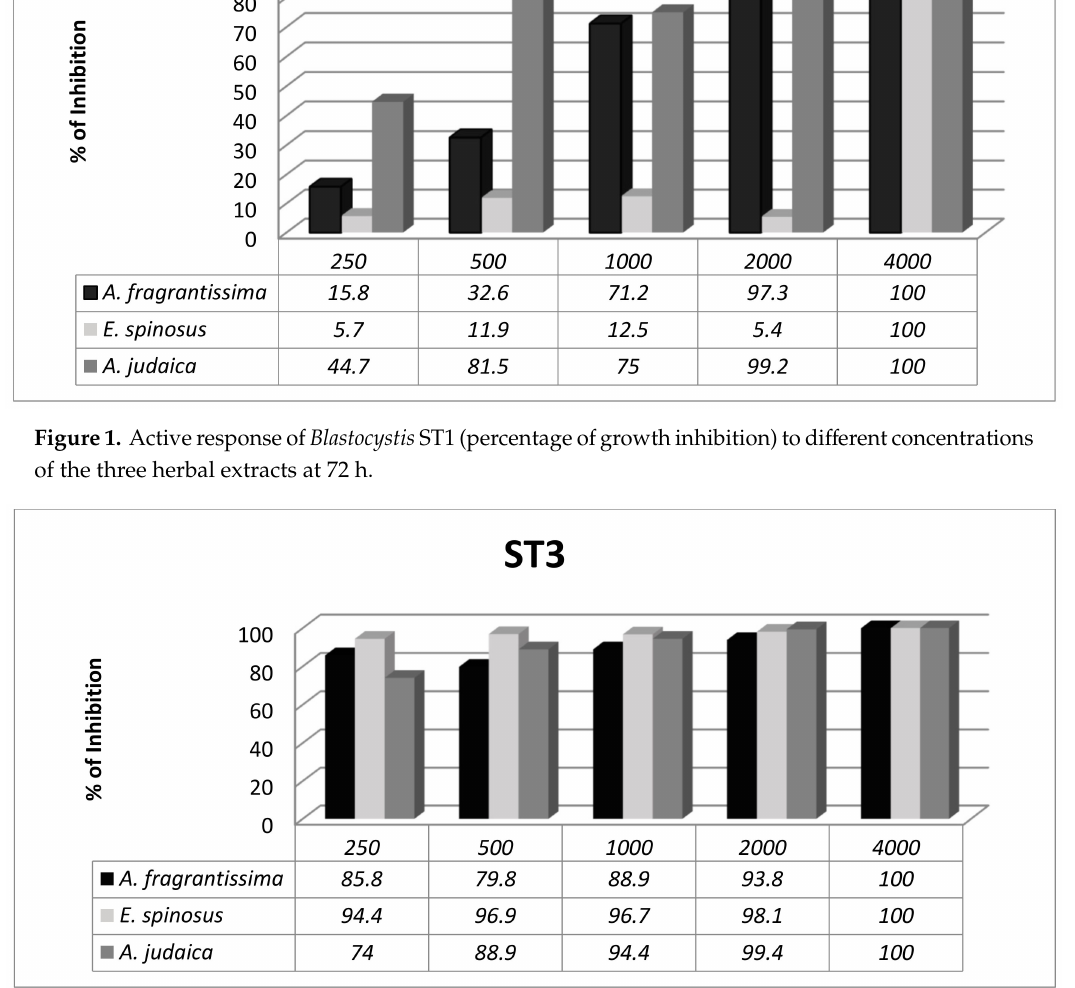
Figure 2. Active response of Blastocystis ST3 (percentage of growth inhibition) to di ff erent concentrations of the three herbal extracts at 72